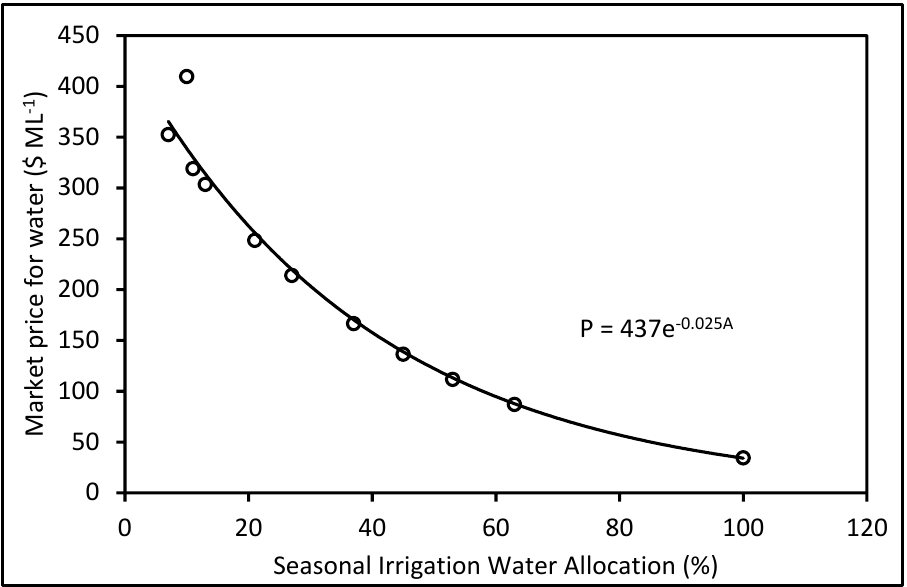
Figure 3. Water price as a function of seasonal water allocation in the Murrumbidgee valley of NSW, Australia.